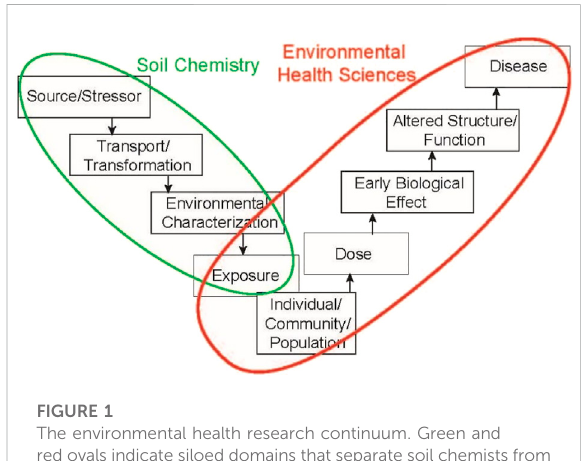
FIGURE 1 The environmental health research continuum. Green and red ovals indicate siloed domains that separate soil chemists from environmental health scientists. Redrawn from (USEPA, 2003).